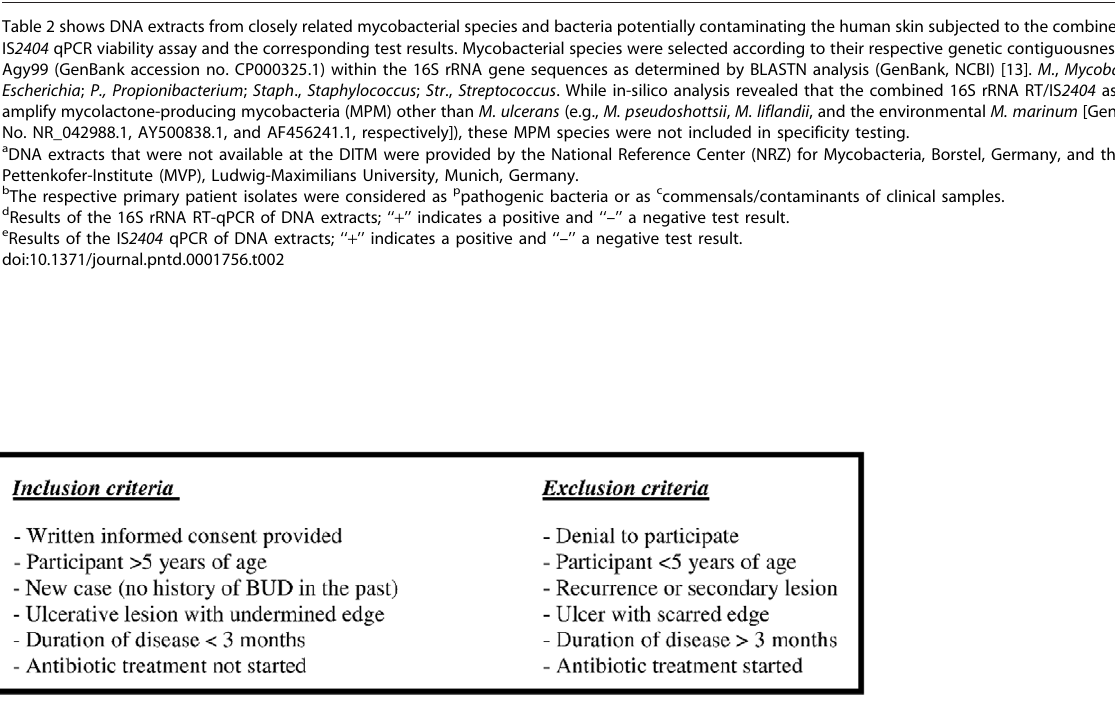
Figure 1. Enrolment criteria for the pre-treatment study population. Figure 1 describes enrolment criteria for clinically suspected BUD patients presenting at Agogo Presbyterian Hospital ( n =14) and Tepa Governmental Hospital ( n =10), Ghana, respectively. None of the eligible study participants was excluded. doi:10.1371/journal.pntd.0001756.g001 PLOS Neglected Tropical Diseases |